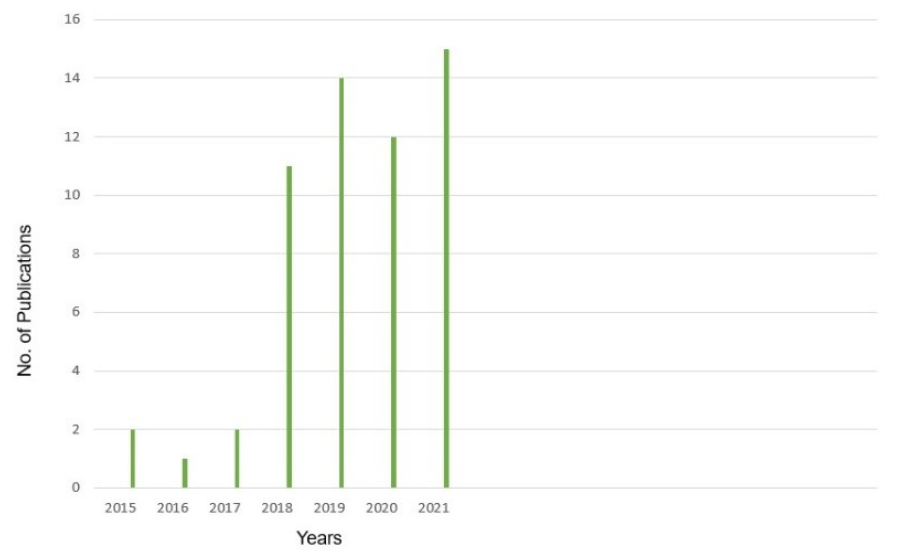
Figure 2. Year-wise publications in journals from 2015 to